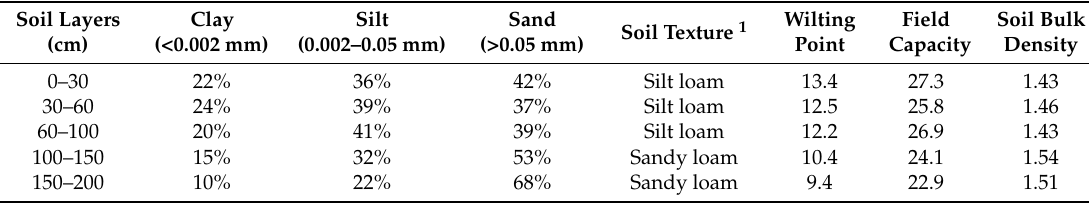
Table 2. Soil physical properties prior to the start of the experiment at the Xuchang experiment station, North China Plain, in